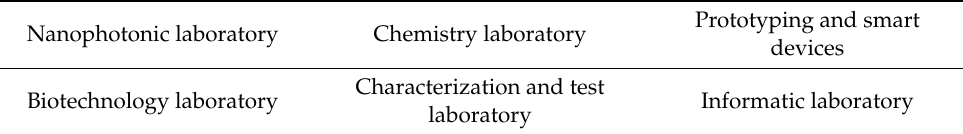
Table 1. Technological areas of the CNOS